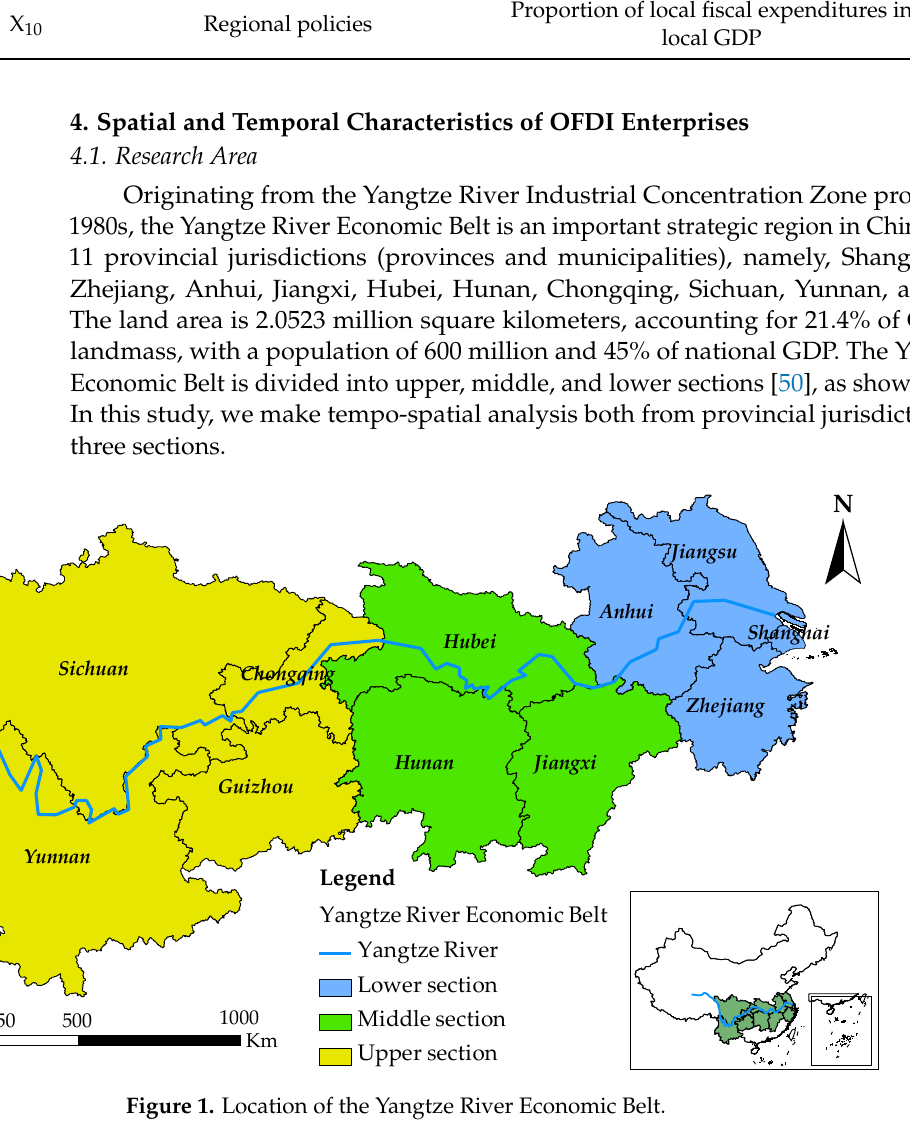
Table 1. Selection and interpretation of explanatory variables.